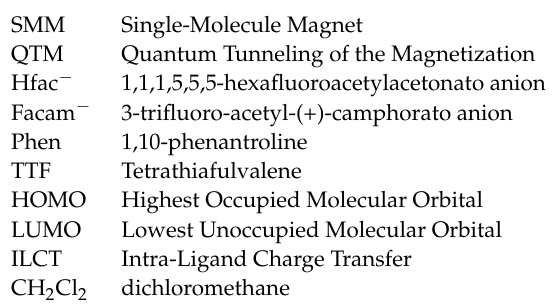
applied magnetic field between 2 and 13 K for 2 ; Figure S21: Frequency dependence of the in-phase ( χ M ’) and out-of-phase ( χ M ”) components of the ac susceptibility measured on powder at 2 K and 1200 Oe with the best-fitted curves (red lines) for 2 ; Figure S22: Normalized Cole–Cole plot for 2 at several temperatures between 2 and 13 K under a 1200 Oe applied magnetic field. Black lines are the best-fitted curves; Figure S23: Temperature dependence of the relaxation time for 2 at 1200 Oe in the temperature range 2–13 K. Greenline corresponds to the thermally activated contribution (Orbach process with the parameters given in the main text). Figure S24: Temperature dependence of the relaxation time for 2 at 0 Oe (full gray circles) and 1200 Oe (open gray circles) in the temperature range of 2–15 K with the best-fitted curve (full black line) with the combination Orbach + Raman + QTM (for H = 0 Oe) processes. The Orbach, Raman, and QTM contributions to the relaxation time are respectively represented in the dashed green line, dashed red line, and dashed orange line (the parameters are given in the main text). Table S1: X-ray crystallographic data for ( 1 ) · 2(C 7 H 16 ) and ( 2 ) · 2(C 6 H 14 ); Table S2: SHAPE analysis of the coordination polyhedra around the lanthanide in the polymeric compounds; Table S3: Selected bond lengths for ( 1 ) · 2(C 7 H 16 ) and ( 2 ) · 2(C 6 H 14 ) in Å; Table S4: Oxidation potentials of the complexes 1 and 2 (V vs. SCE, nBu 4 NPF 6 , 0.1 M in CH 2 Cl 2 at 100 mV.s − 1 ); Table S5: Best fitted parameters ( χ T , χ S , τ and α ) with the extended Debye model for compound 1 at 2 K in the magnetic field range 200–3000 Oe; Table S6: Best fitted parameters ( χ T , χ S , τ and α ) with the extended Debye model for compound 1 at 1000 Oe in the temperature range 2–4.25 K; Table S7: Best fitted parameters ( χ T , χ S , τ and α ) with the extended Debye model for compound 2 at 0 Oe in the temperature range 2–14 K; Table S8: Best fitted parameters ( χ T , χ S , τ and α ) with the extended Debye model for compound 2 at 2 K in the magnetic field range 200–2400 Oe; Table S9: Best fitted parameters ( χ T , χ S , τ and α ) with the extended Debye model for compound 2 at 1200 Oe in the temperature range 2–13